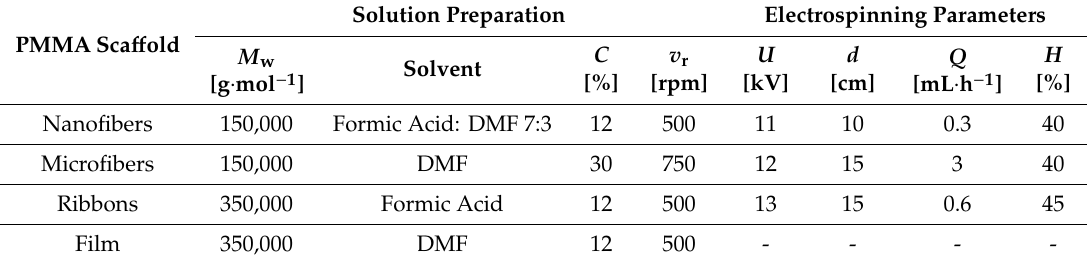
Table 1. Details of solution preparation for electrospinning and spin-coating of poly(methyl methacrylate) (PMMA) including—molecular weight ( M w ), concentration w / w ( C ), solvents, and the rotation speed of stirrer ( V r ); the electrospinning parameters—voltage ( U ), distance needle to collector ( d ), flow rate ( Q ), and humidity ( H ), used to produce PMMA sca ff olds with nanofibers, microfibers, and